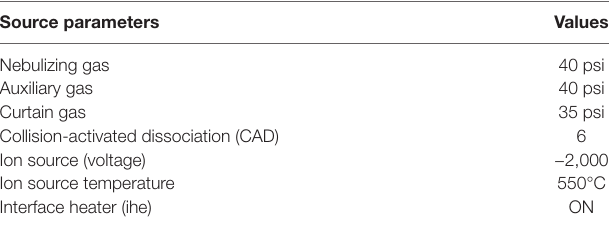
TABLE 2 | ESI-MS/MS source parameters for OLM, OLM D 6 , HCTZ, and HCTZ 13 C D